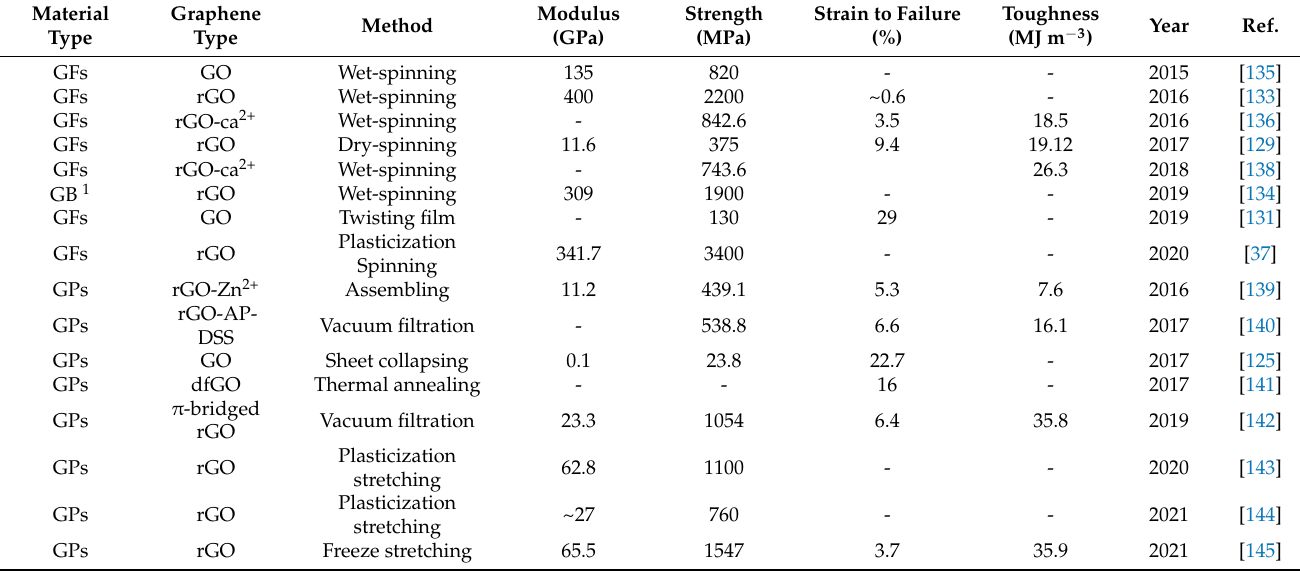
Table 2. Summary of up-to-date mechanical properties of GFs and